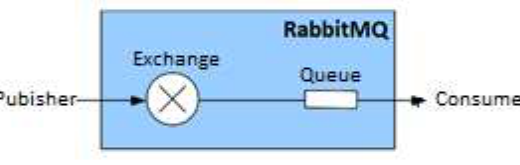
Figure 1. Working principle of RabbitMQ